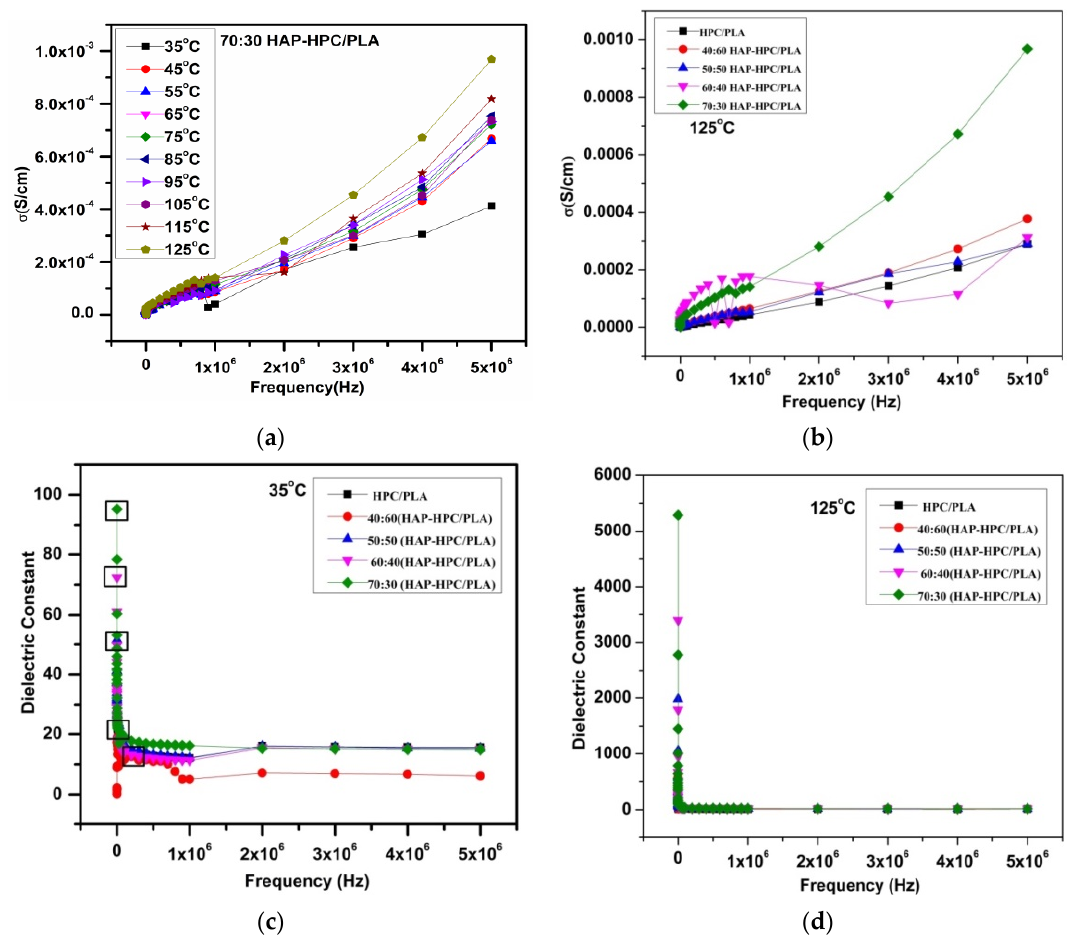
Figure 1. ( a ) Conductivity of HAP-HPC/PLA (70:30); ( b ) different ratios of HAP-HPC/PLA; ( c ) dielectric constant at 30 ◦ C of 0% HAP and HAP-HPC/PLA; ( d ) dielectric constant at 125 ◦ C of 0% HAP and